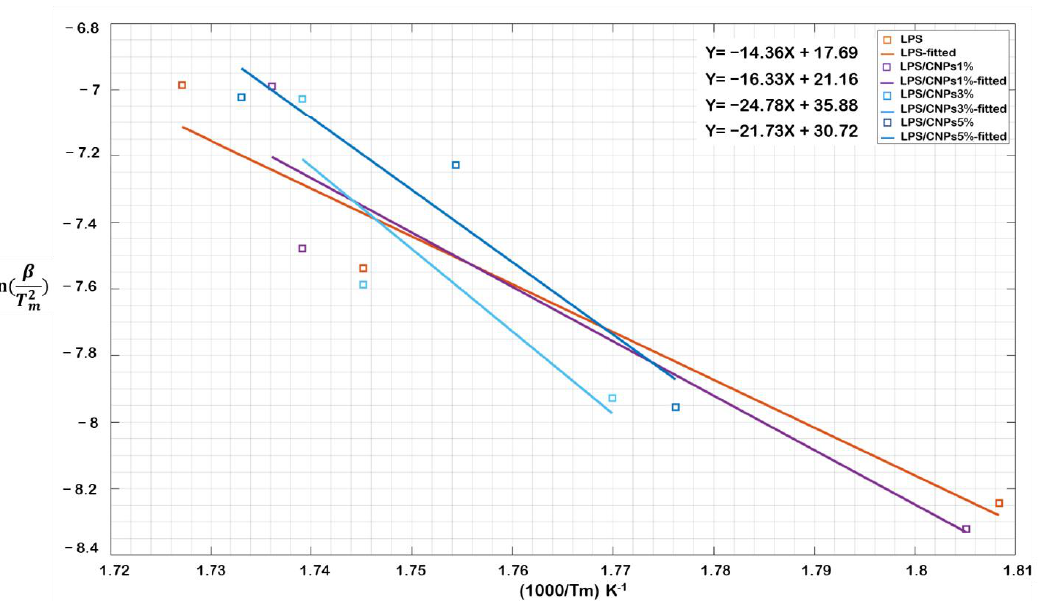
Figure 6. Kissinger’s relationship chart for LPS and Figure 6. Kissinger ’ s relationship chart for LPS and nanocomposites.